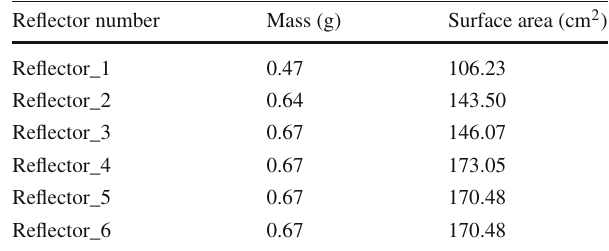
Table 2 Vikuiti reflector masses and surface